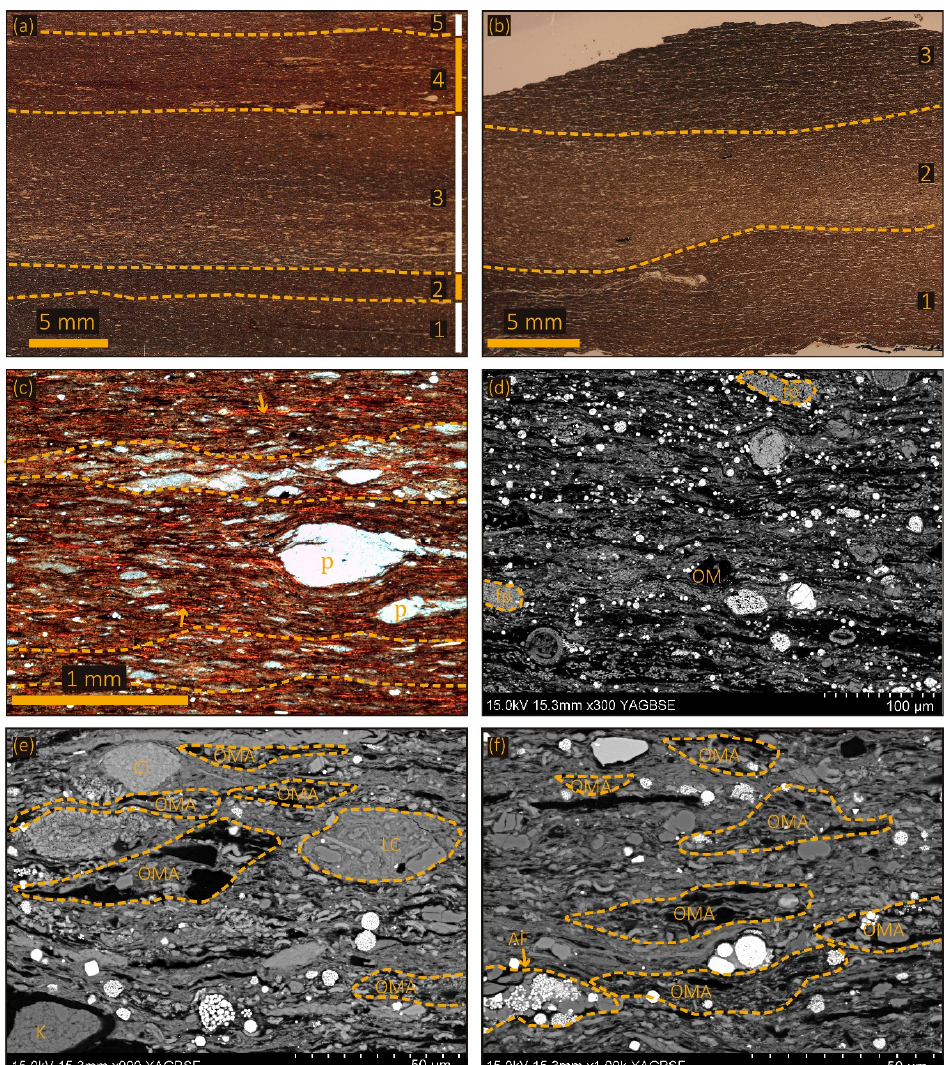
Figure 4. Facies 2: Organic material and calcareous pellet-rich, laminated mudstone. ( a ) Low powered optical micrograph of sample EB 46.50 m showing normally graded beds that have erosional bases (a to d). ( b ) Low powered optical micrograph of sample EB 45.50 m showing apparent compositional banding between the lamina. Brighter laminae are carbonate-rich and the darker laminate are more clay-rich ( c ) Optical micrograph of sample EB 46.50 m. Note the apparent compositional banding between the lamina (outlined by yellow dashed lines). Calcareous faecal pellets are labelled as p and red algal macerals are marked by yellow arrows. ( d ) Backscattered electron photomicrograph of sample EB 36.92 m. Calcareous faecal pellets (fp) and equant organic material (OM) float in a clay and organic rich matrix. Pyrite is present as framboids, microcrystals and as a replacement mineral (high ƞ ). ( e , f ) Backscattered electron photomicrographs of sample EB 46.50 m. Lithic clasts (LC), organo-mineral aggregates (OMA) and clay aggregates (Cl), and agglutinated foraminifer (AF) sit within a clay and coccolith-rich matrix. Authigenic kaolinite (K) infills some of the organic matter.